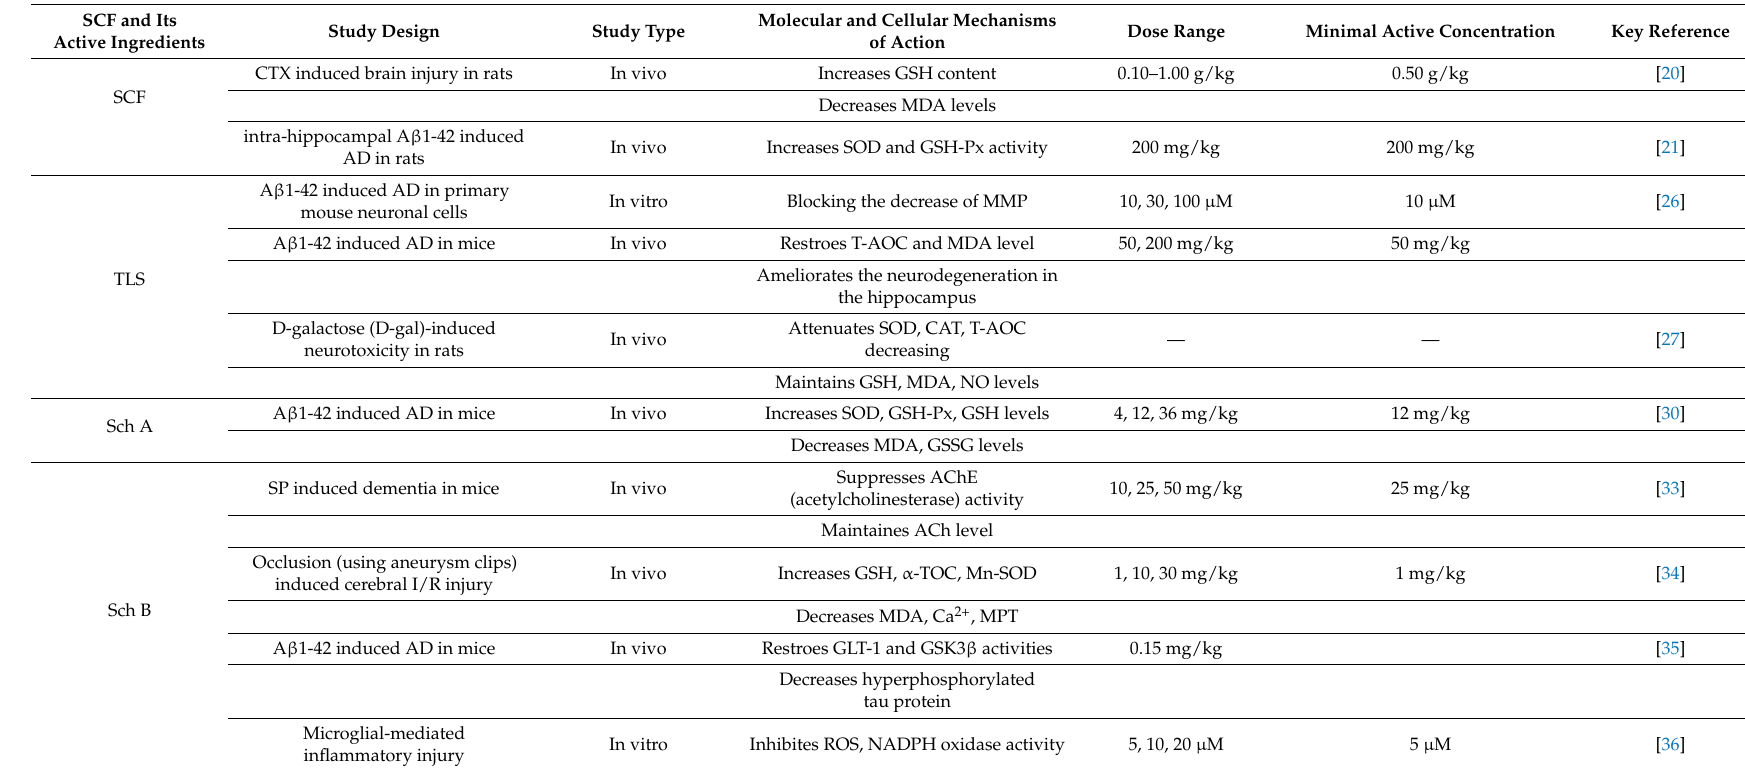
The pharmacological data of SCF and its active ingredients in protecting against NDs by anti-oxidative